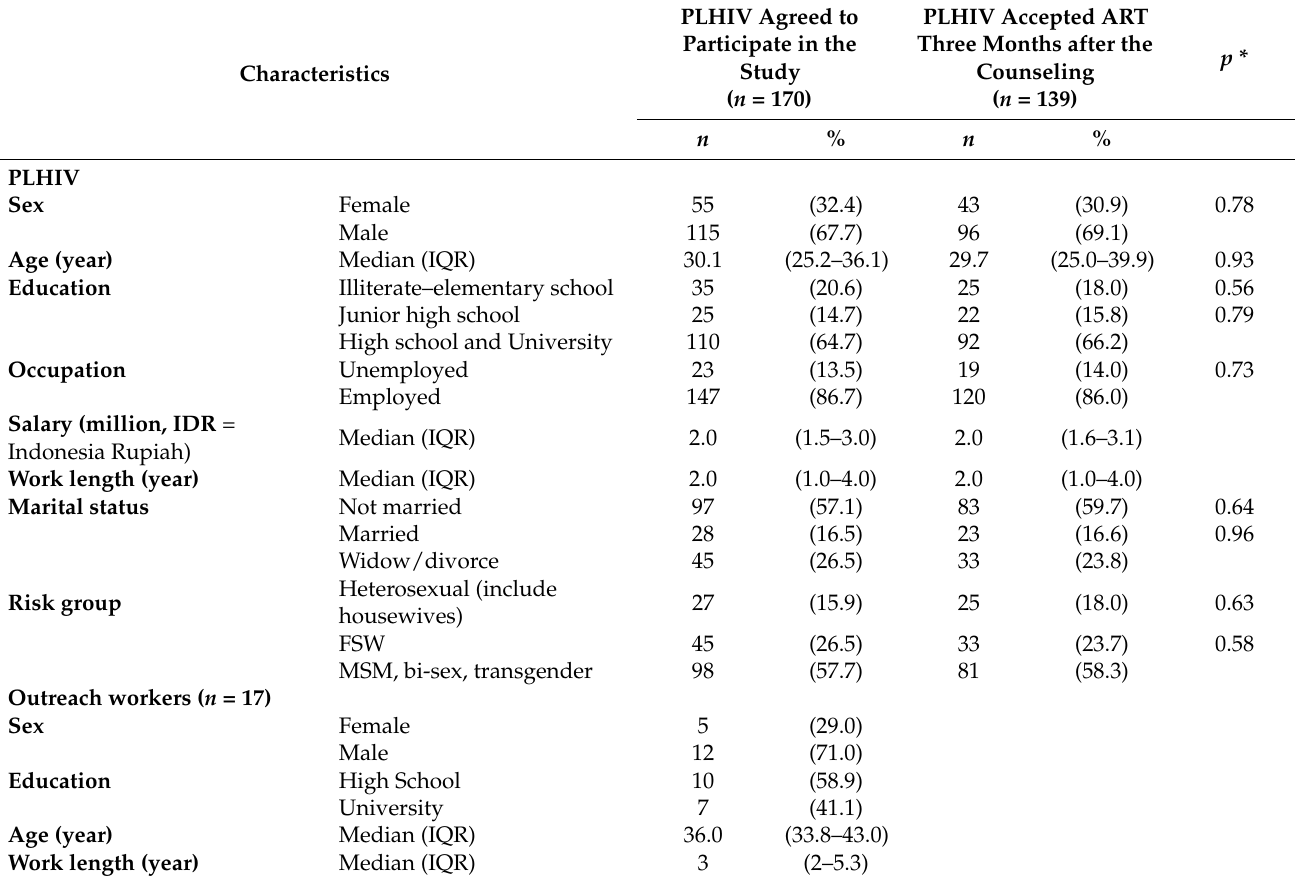
Table 1. Characteristics of PLHIV and